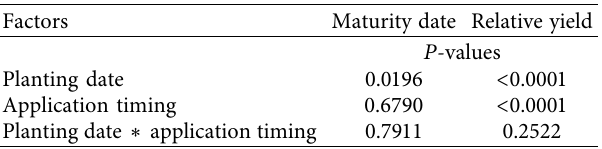
Table 6: Relative yield of soybean at four planting dates averaged stage of